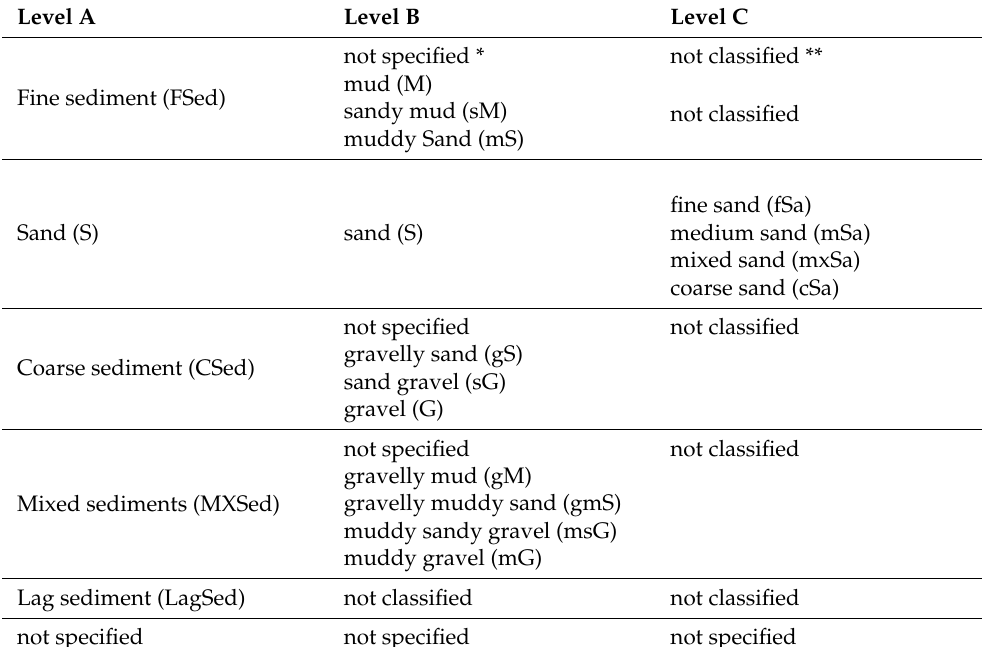
Table 2. BSH sediment classification scheme for seafloor mapping in German marine waters [36]. Level A category was used to classify our ground-truth